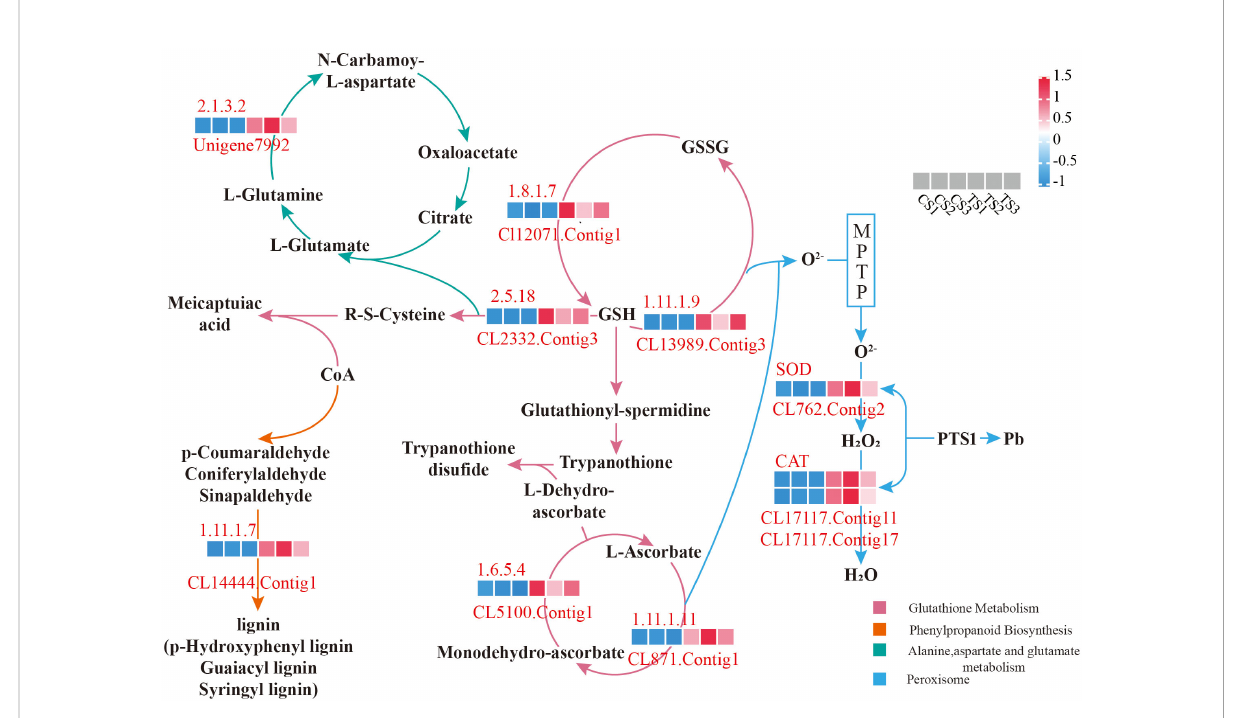
FIGURE 4 Partial possible molecular mechanism of Pb tolerance in roots of P. crinitum